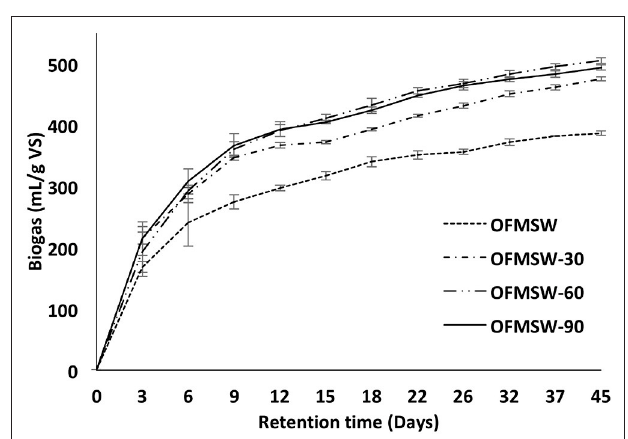
FIGURE 13 | Accumulated biogas and Methane yield from pretreated OFMSW.